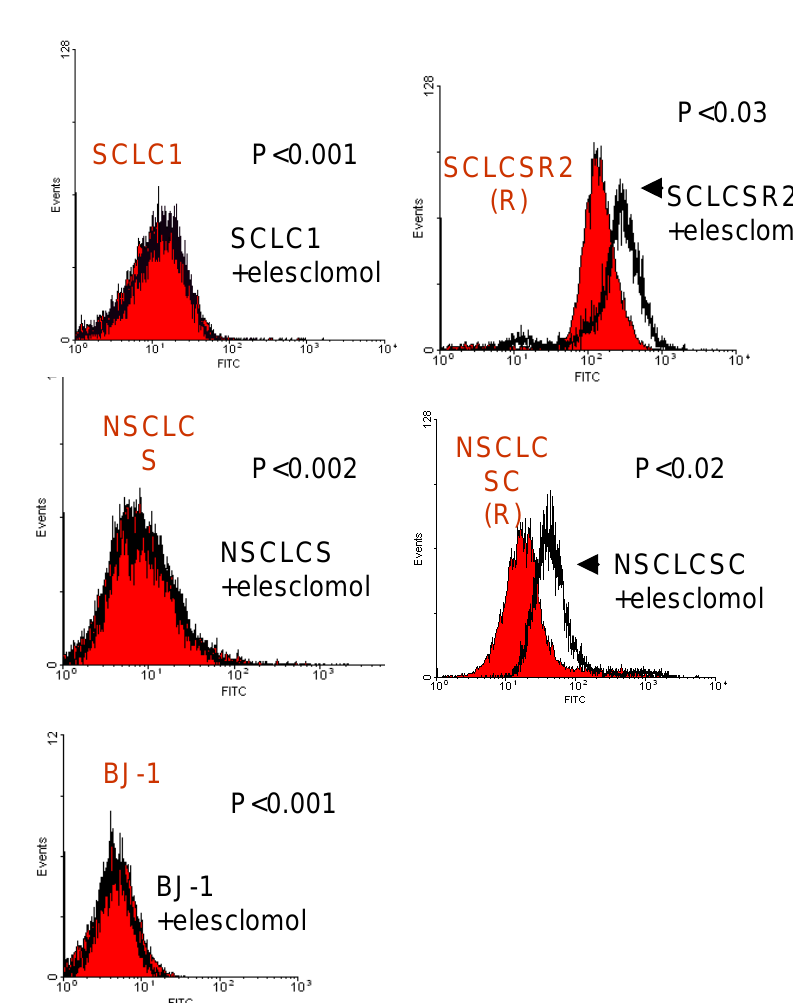
Figure 5. Flow cytometry analysis of ROS in a pair of SCLC and NSCLC cell lines detected by DCF-DA probe. 10 nM of elesclomol for 24 h greatly induced intracellular ROS levels in the resistant (R) cell lines SCLCSR2 and NSCLCSC whereas in parental cell lines (SCLC1 and NSCLCS) and BJ-1, no significant increase of ROS was seen. Each histogram is representative of three experiments; (nontreated vs.